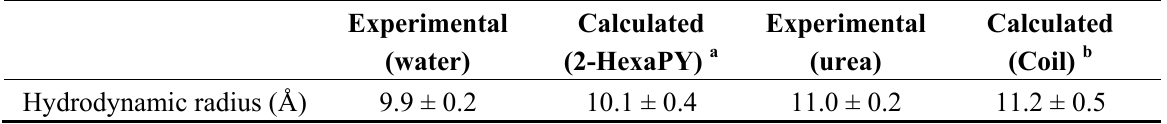
Table 2 . Comparison of the experimental hydrodynamic radius estimated in water and urea with the values back-calculated for the obtained ensemble of 2-HexaPY(a) and the TraDES random coil ensemble